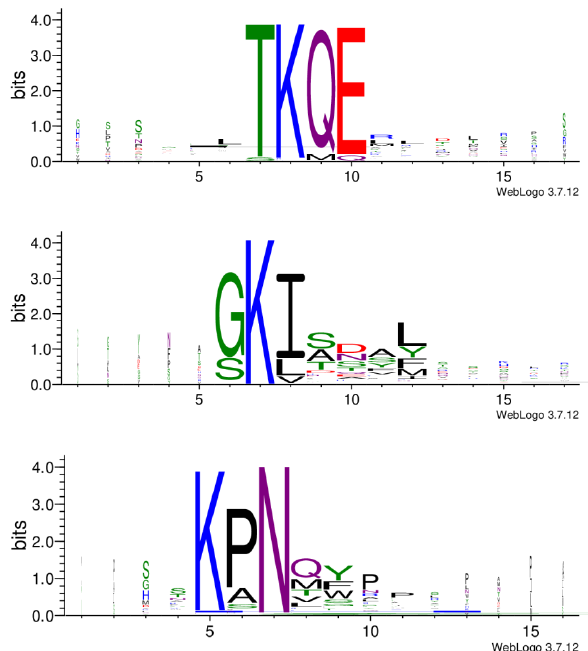
Figure 6. Three peptide clusters generated by Hammock. Five hundred and twenty-five peptides were subjected to the Hammock tool. Sequence logos, representing the significance of the individual amino acid residues were created with WebLogo.